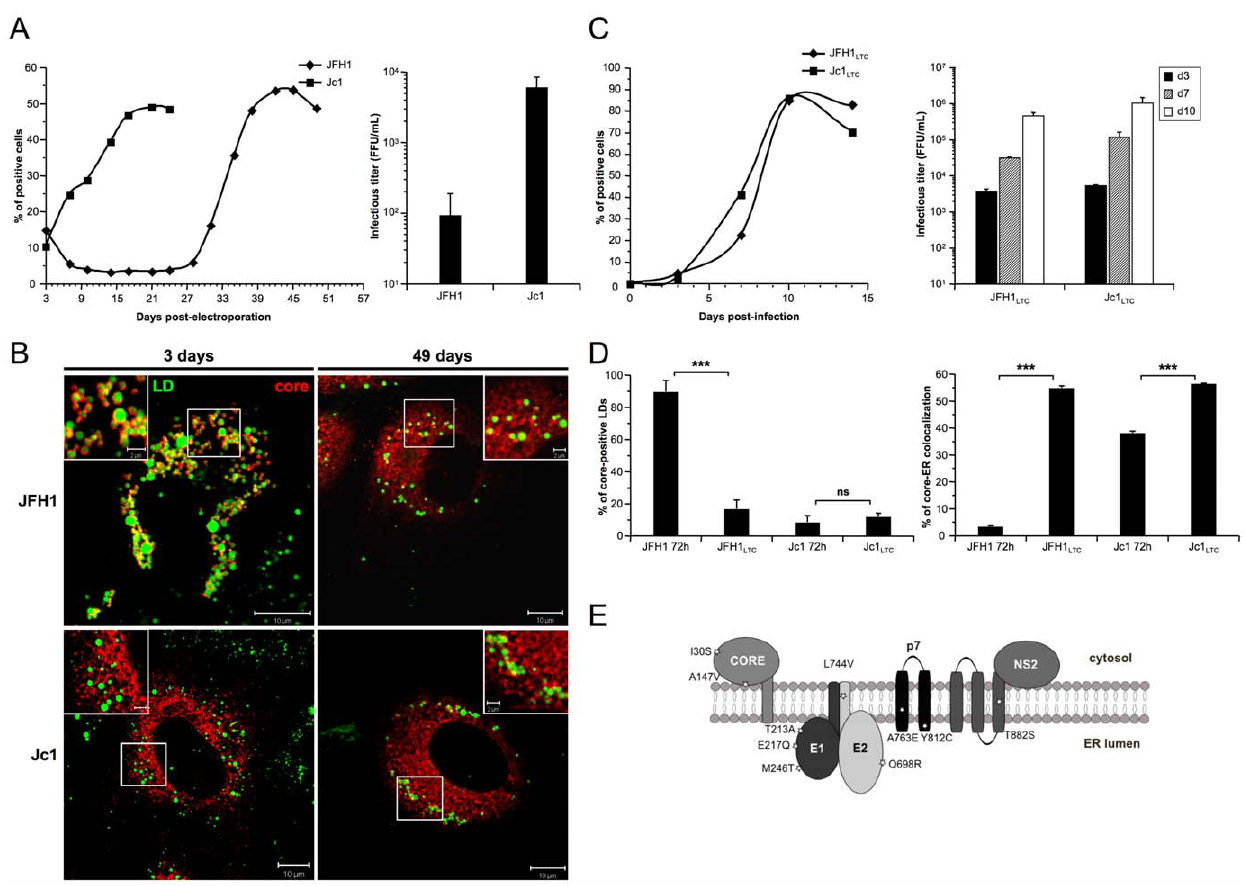
Figure 3. core re-localization in the ER after adaptation of JFH1 HCVcc in long-term culture. Huh7.5 cells were transfected with RNAs from the full-length genomes of JFH1 and Jc1 HCV. The viral spread of the latter viruses was analyzed in these cells culture for up to 49 days (left panel) and the infectious titers, determined as NS5A-FFU/ml (mean 6 SD, n=4) in the supernatants of transfected cells (right panel), were measured 3 days post- transfection ( A ). Cells were fixed at day 3 or day 49 post-transfection and stained for LDs and HCV core. Colocalization of core proteins (red channel) with LDs (green channel) was analyzed by confocal microscopy. Typical patterns of intracellular localization of either protein are shown. The scale bars are provided in each panel as well as in zooms from squared areas ( B ). The supernatants of HCVcc-expressing cells were collected from these cultures at day 3 (JFH1 and Jc1 HCVcc) and at day 49 (JFH1 LTC and Jc1 LTC HCVcc) and used to infect fresh Huh7.5 cells (MOI=0.02). The viral spread of the latter viruses was analyzed in these cells culture for up to 15 days (left panel) and the infectious titers, determined as NS5A-FFU/ml (mean 6 SD, n=4) in the supernatants of these cells (right panel), were measured 3, 7 and 10 days post-infections ( C ). JFH1 LTC and Jc1 LTC HCVcc-infected cells were fixed 72 h post-infection and stained for LDs, Calnexin and HCV core proteins. Colocalization of core proteins with LD or ER was analyzed by confocal microscopy. The frequency of JFH1 or Jc1 core-positive LDs (mean % 6 SD) was determined in HCVcc-containing cells stained for core and LDs (left panel). The percentages of core-ER colocalization (mean % 6 SD) were determined by expressing the coefficients of determination based on Pearson’s correlation coefficients of colocalization of core and Calnexin (right panel). For each condition, 30–50 cells were quantified. (*), P , 0.05; (**), P , 0.01; (***), P , 0.001; (ns), no significant difference ( D ). Schematic representation of residues in HCV proteins that were mutated in core, E1, E2, p7 and NS2 sequences of several JFH1 LTC clones isolated. The changes in residues refer to the sequence of the parental JFH1 strain ( E ).